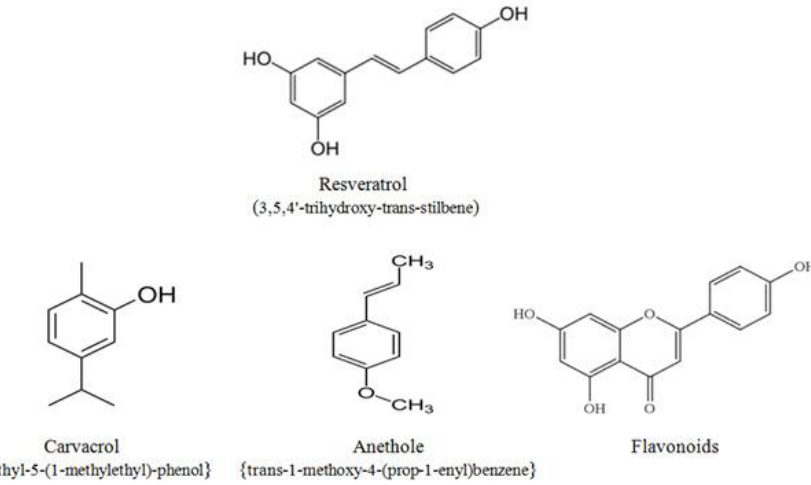
Figure 1. Basic structural formula of resveratrol and the main bioactive components of essential oils